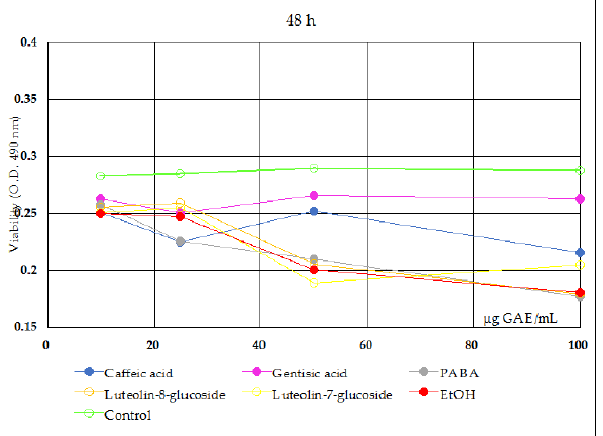
Figure 3. Caco-2 cell viability treated with the five reference compounds (phenolics), at 48 h